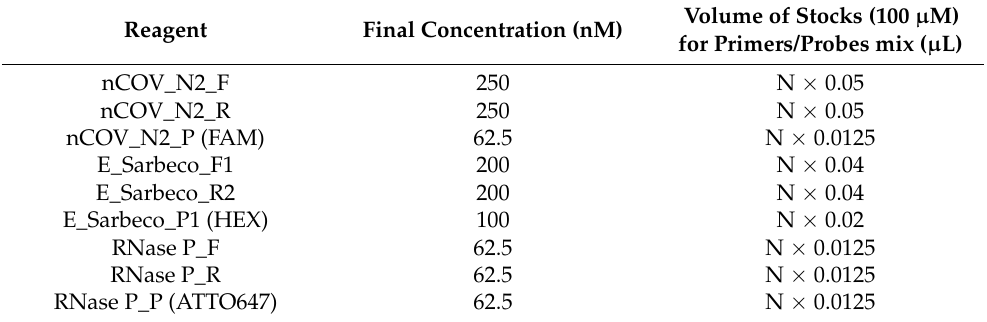
Table 1. Primers and probes required in the reaction mix. The final concentration of each reagent is indicated. A primers/probes mix for N reactions can